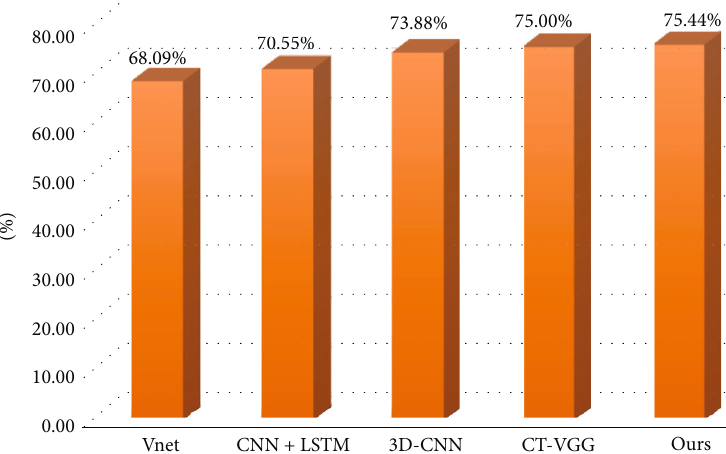
Figure 8: Comparison of recognition results of di ff erent network models applied to RML